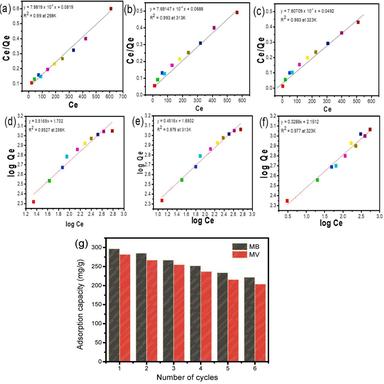
Shows different MB adsorption Isotherm models Langmuir adsorption at (a) 298 K, (b) 313 K, (c) 323 K; Freundlich adsorption (d) 298 K, (e) 313 K, (f) 323 K; and (g) Regeneration of adsorbent for adsorption/desorption of MB and MV dye.